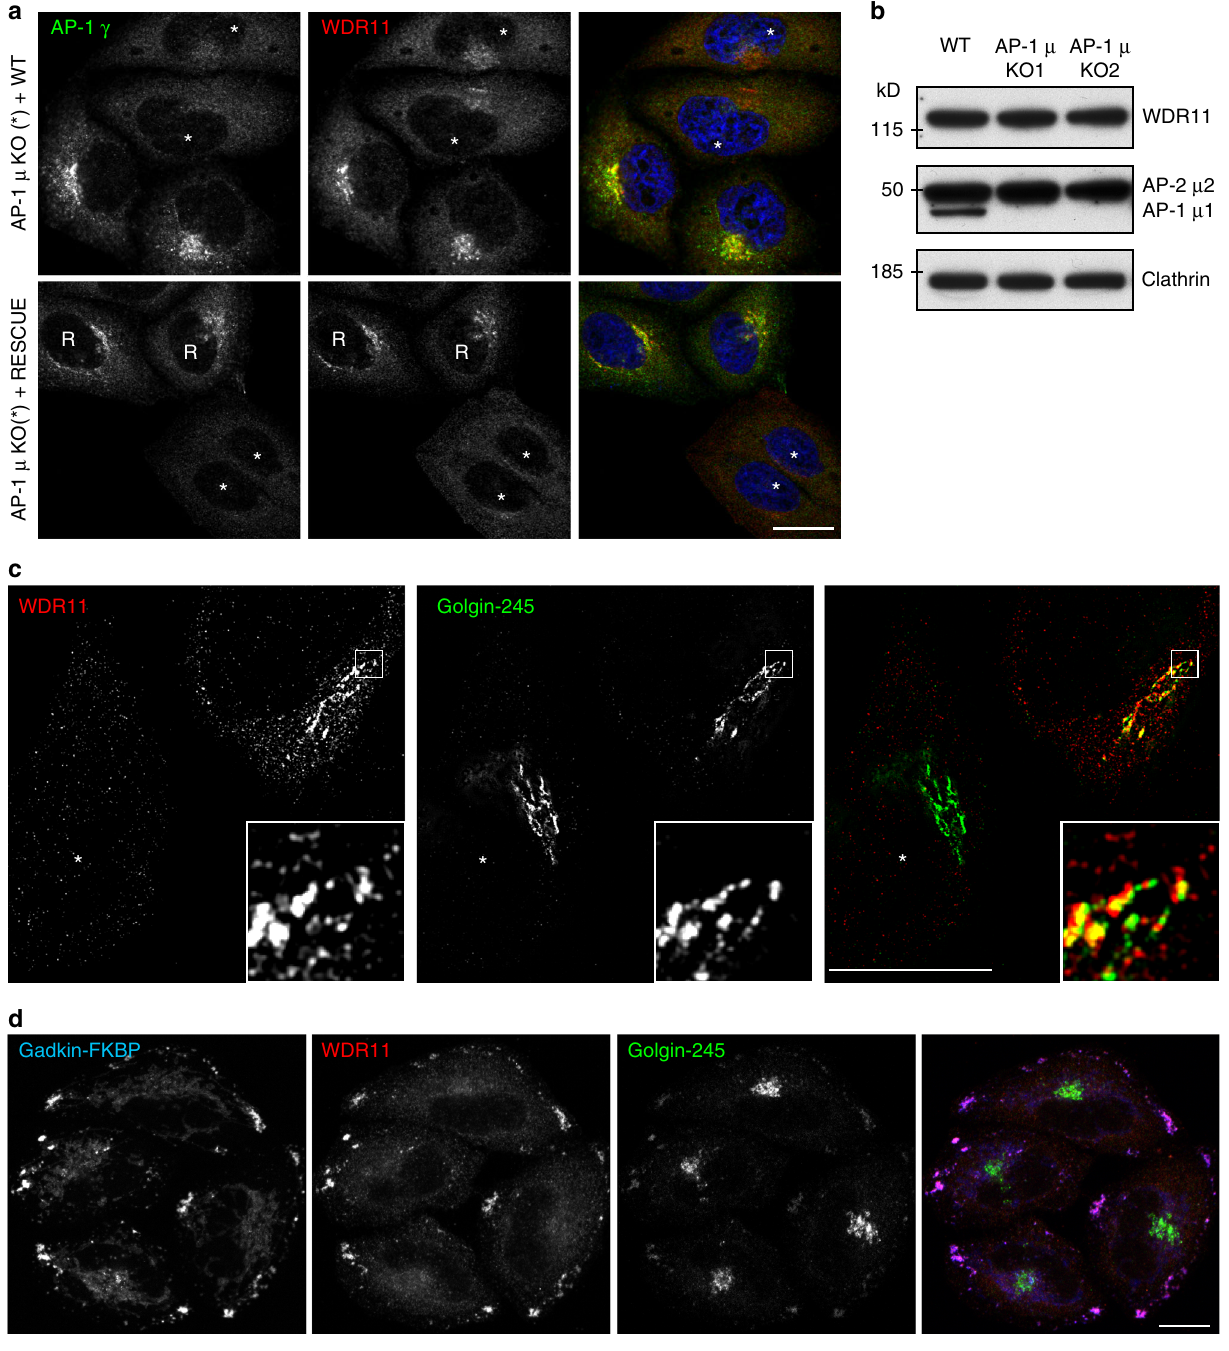
Fig. 7 Characterisation of the WDR11-binding compartment. a Mixed populations of wild-type and AP-1-knockout cells, or AP-1-knockout cells and rescued AP-1-knockout cells, were stained for WDR11 and AP-1 γ . The juxtanuclear localisation of WDR11 is diminished in AP-1-knockout cells (asterisks), but appears normal in the rescued cells (R). b Expression of WDR11 is unaffected in AP-1-knockout cells. c Structured illumination microscopy of wild-type and WDR11-knockout cells double labelled for WDR11 and endogenous golgin-245. There is incomplete colocalisation of the two proteins and additional punctate labelling for WDR11. d Gadkin-FKBP ‘ knocksideways ’ cells were treated with rapamycin (200 ng/ml) for 30 min to induce AP-1-derived vesicles to become crosslinked to mitochondria and pulled out to the cell periphery. The cells were then labelled for gadkin-FKBP, WDR11 and golgin-245. WDR11 moves out to the cell periphery, while golgin-245 remains mainly juxtanuclear. Scale bars: 20 µ